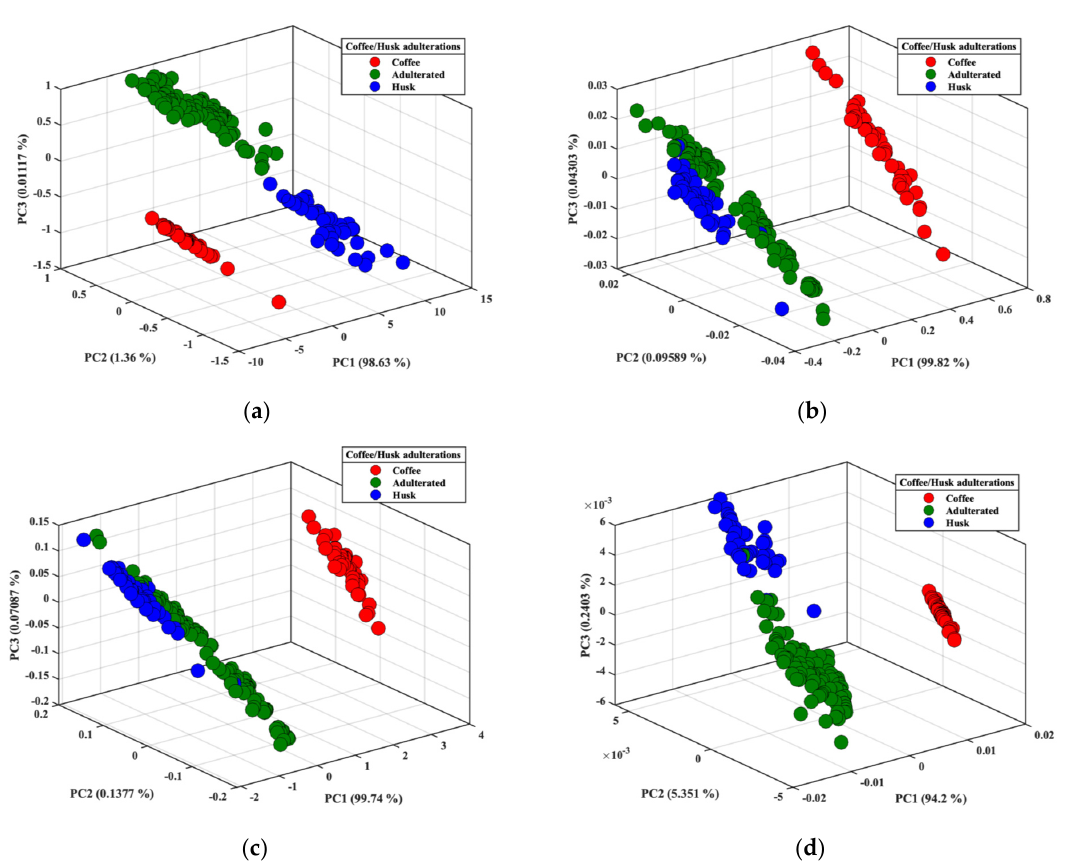
Figure 3. PCA score scatter Robusta coffee and adulterants: ( a ) raw, ( b ) MSC, ( c ) SNV and ( d ) FD.